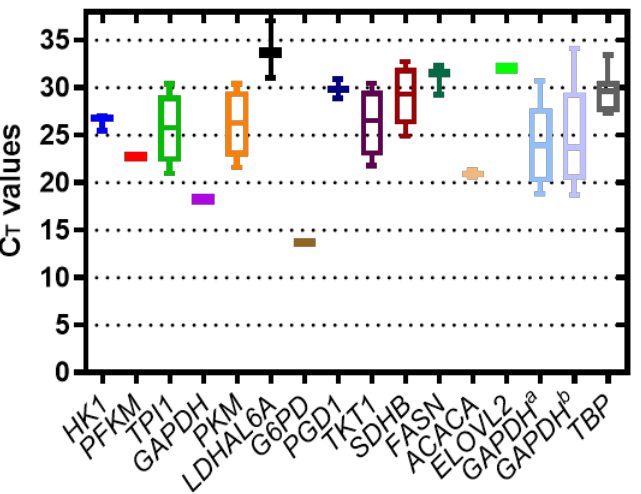
Figure 1. Expression levels of the sixteen candidate reference genes in the HMC3 microglial cell line (ATCC ® CRL-3304™). The variation is shown as median values and 25th to 75th percentiles (boxes), with whisker plots indicating the lower and upper values of C T of the candidate reference genes. The values of three biological replicates are shown. The graph was plotted with the GraphPad Prism 9